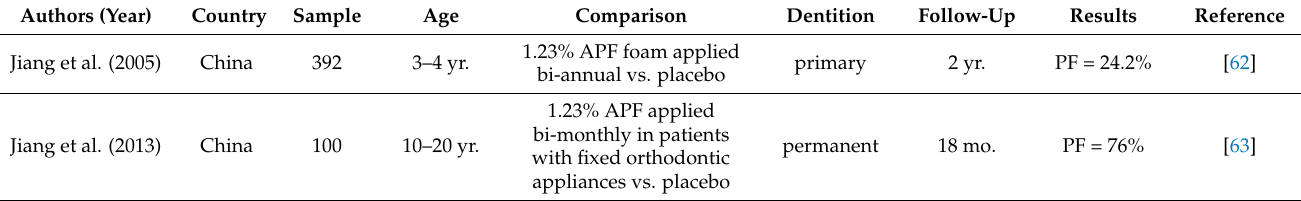
Table 4. Comparative data from clinical trials about professionally applied fluoride foams applied in